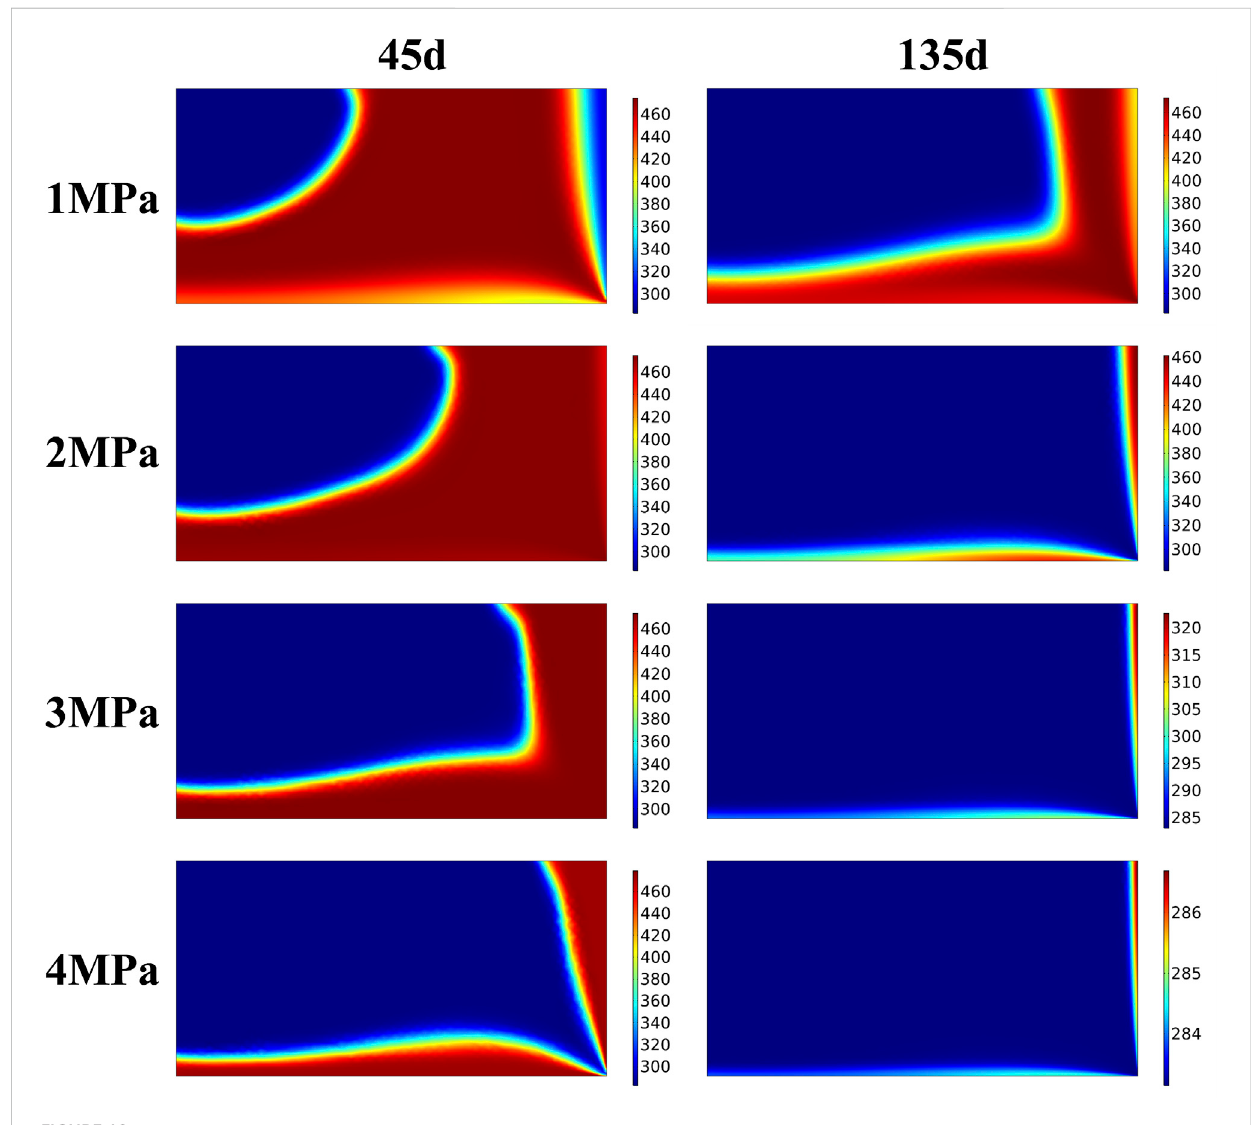
FIGURE 10 Temperature distribution of the system during heat production at different injection